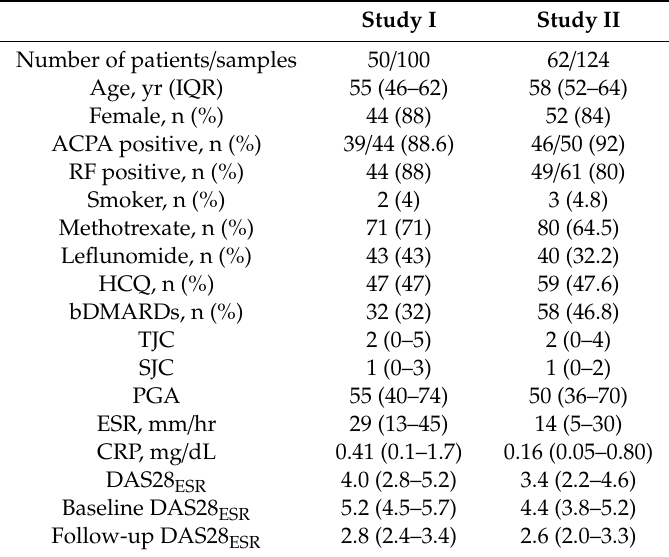
Table A1. Patient characteristics.